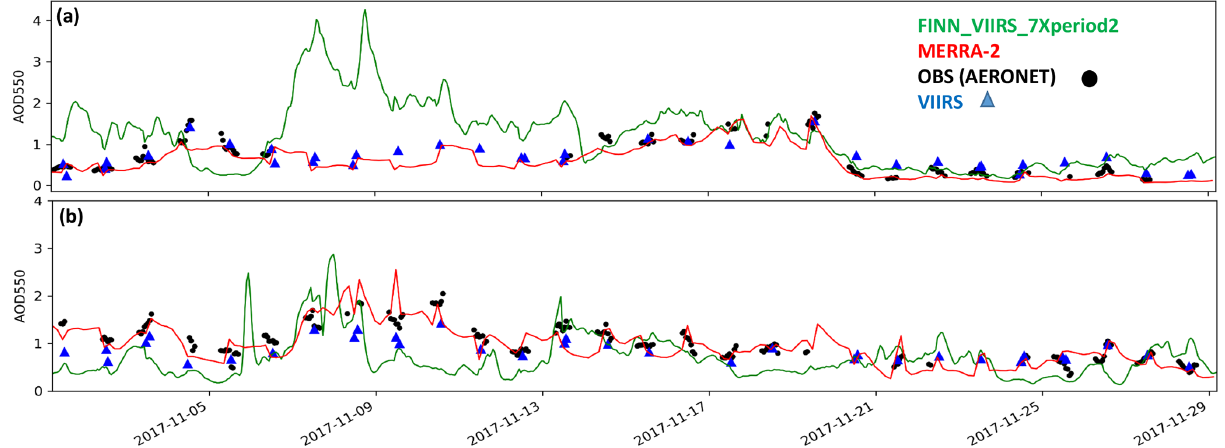
Figure 4. Time series of modeled (green line), VIIRS-retrieved (blue triangles), MERRA-2 (red line), and AERONET (black dots) AOD at 550nm during November 2017 at (a) Jaipur and (b) Kanpur.